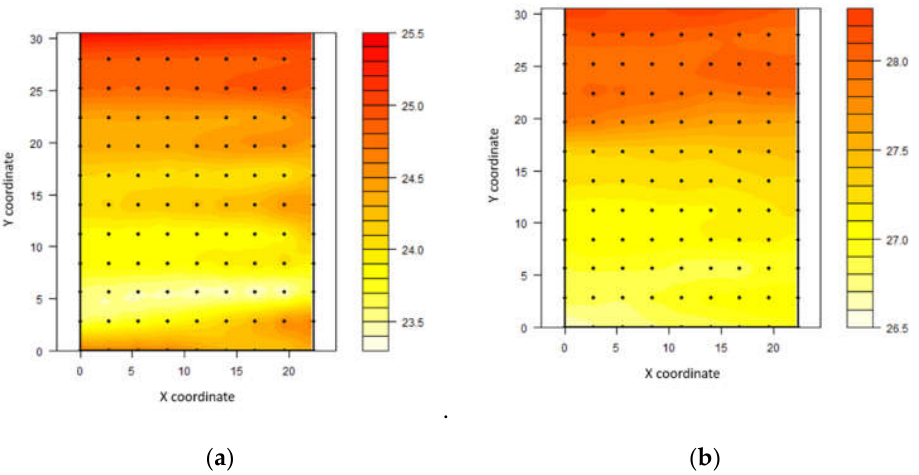
Figure 2. Spatial distribution of air temperature (°C) in compost-bedded pack barn between 09:00 and 12:00 h ( a ) and between 12:00 and 15:00 h ( b ).